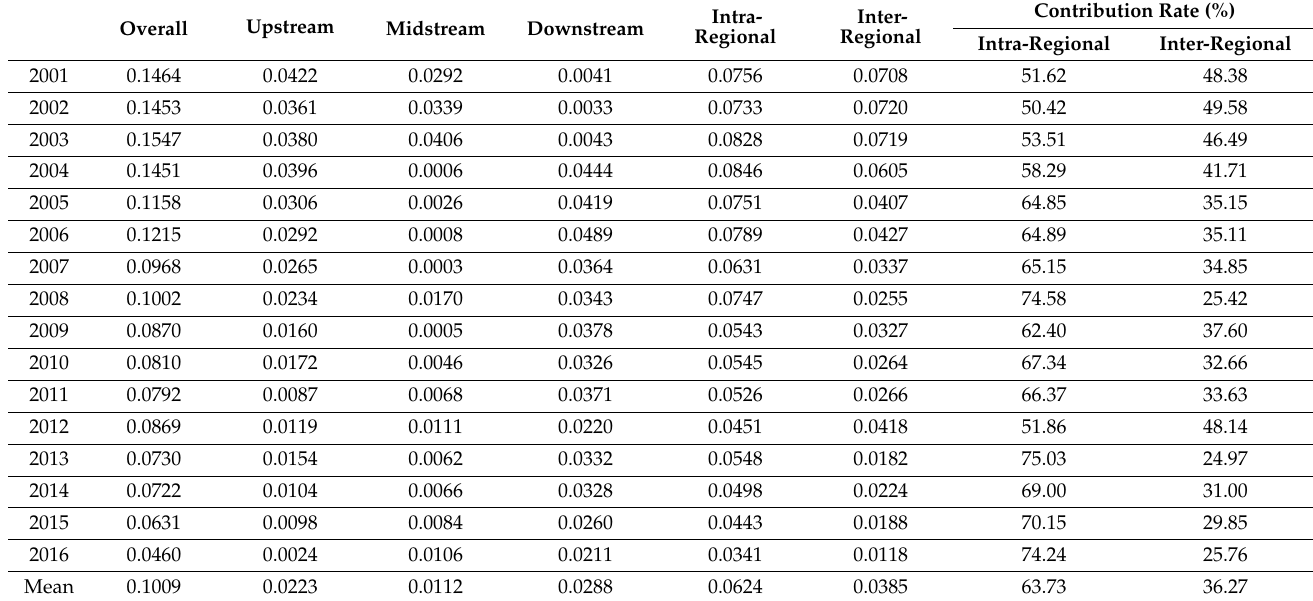
Table 3. Source and contribution rate of the spatial difference of the paper industry in Yangtze River Economic Belt. Overall Upstream Midstream